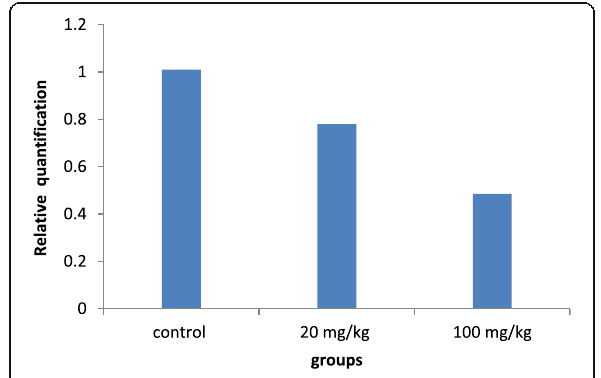
Fig. 3 Effect of bisphenol A on spermatogenesis-associated 7 (SPATA 7) expression in the testis of adult male albino